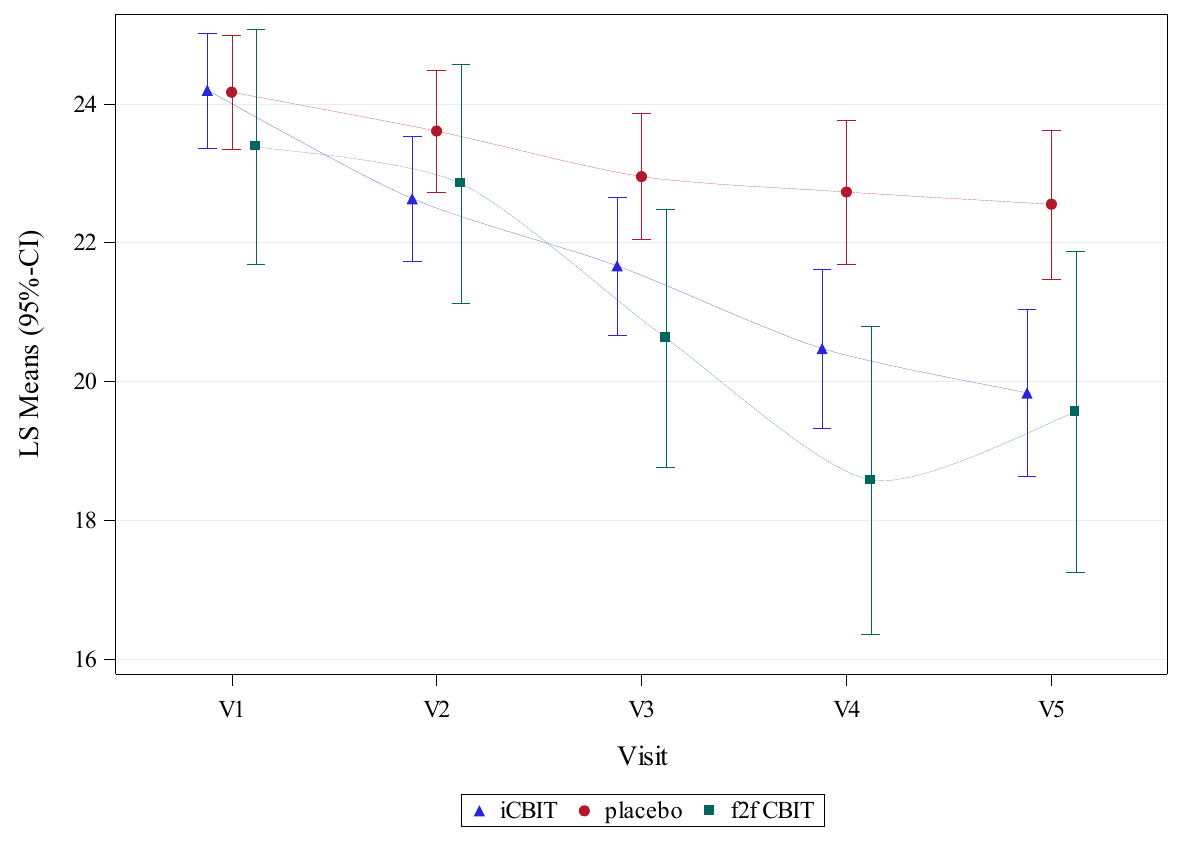
Figure 1. YGTSS-TTS at baseline (V1), during (V2 and V3), and after end of treatment (V4 and V5) in iCBIT compared to f2f CBT and placebo groups. LS means (iCBIT and placebo) for V1–V3 were derived from a mixed model for repeated measures (MMRM) including data for V1–V3 only and excluding patients of the f2f CBIT group (primary analysis model). LS means (iCBIT and placebo) for V4 and V5 each were derived from separate MMRMs including additional data up to V4 and V5, respectively. LS means (f2f CBIT) for V1–3 were derived from a MMRM, including data for V1–V3 only and excluding placebo patients (key secondary analysis model). LS means (f2f CBIT) for V4 and V5 each were derived from separate MMRMs, including additional data up to V4 and V5, respectively.